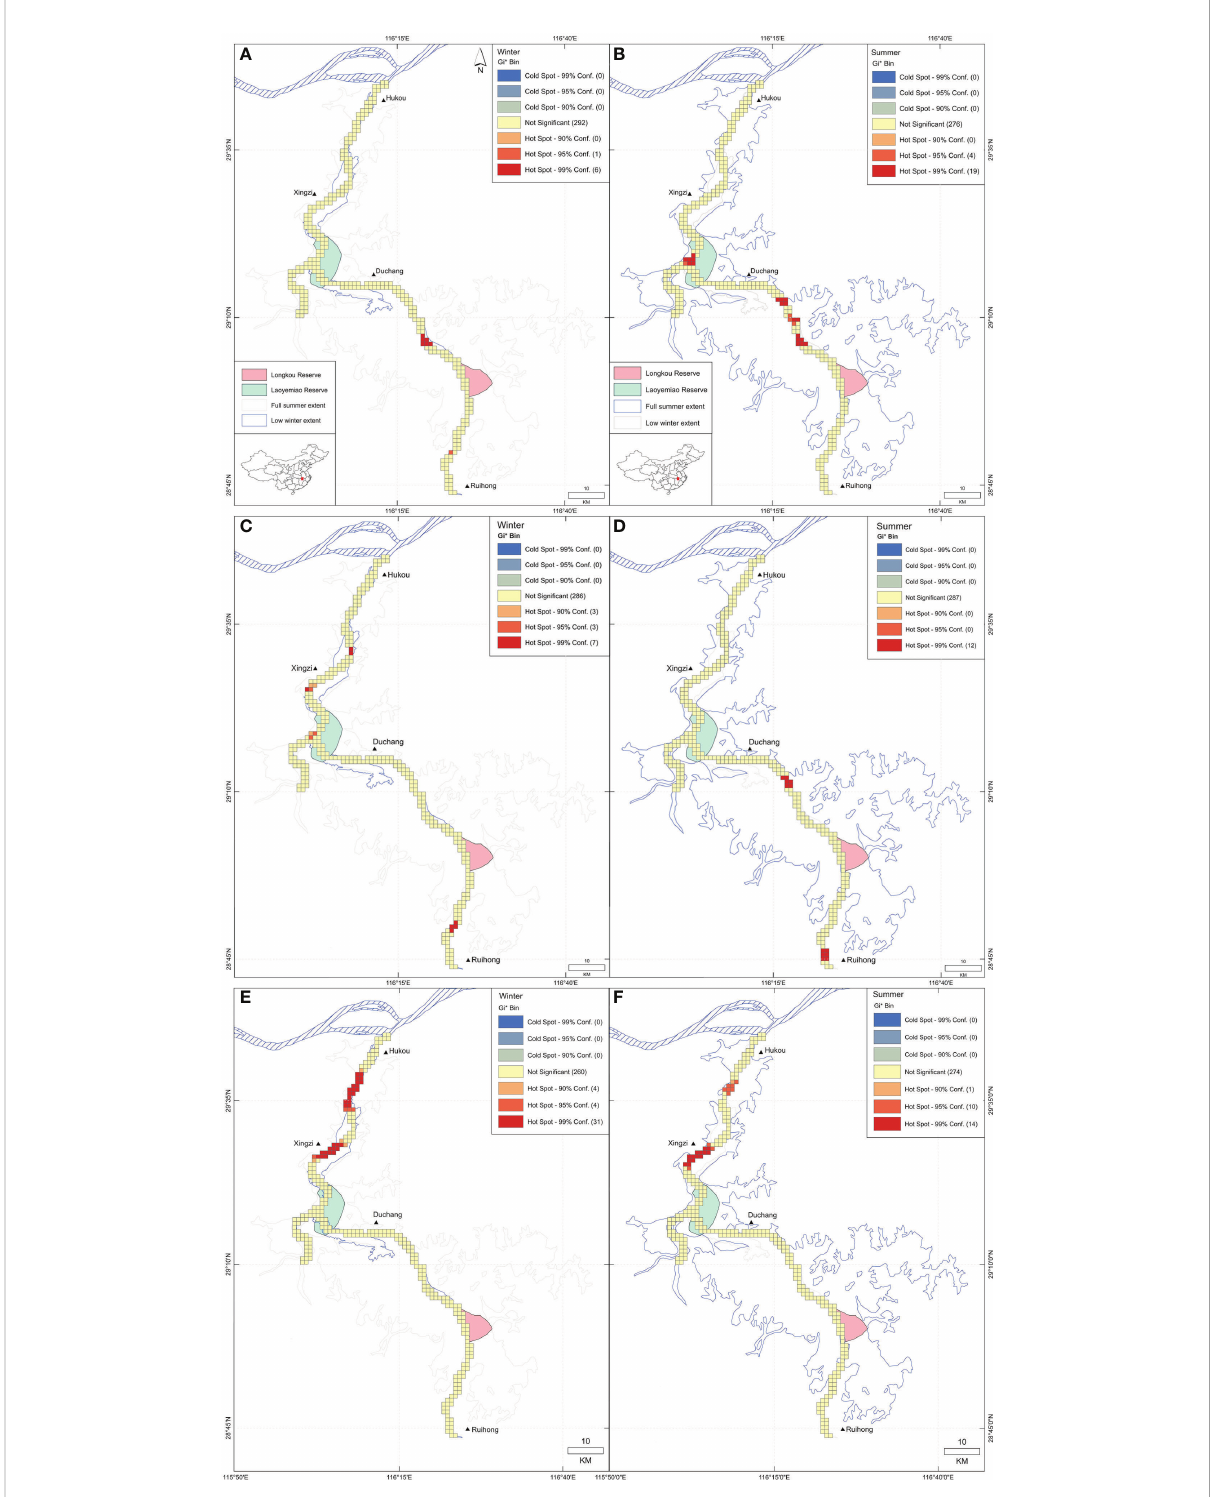
FIGURE 3 Statistically signi fi cant hotspots calculated using Getis-Ord* statistic for (A, B) porpoises, (C, D) fi shing activity, and (E, F) sand-mining activity observed in Poyang Lake during winter (A, C, E) and summer ( B, D, F